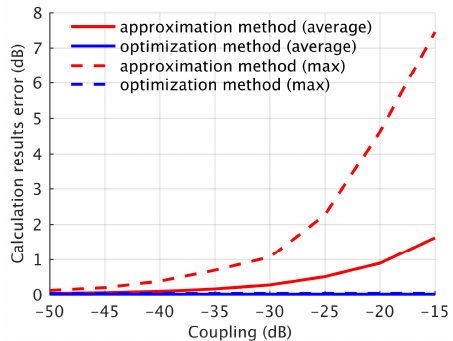
Figure 19. Comparison of coupling errors calculated by approximation method and optimization method.